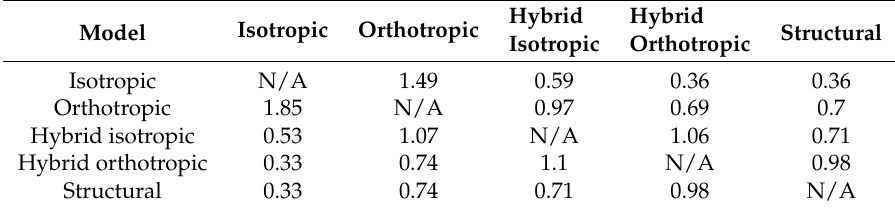
Table 7. Gradients of lines of best fit between each pair of adaptive models for maximum principal strains (above table diagonal) and minimum principal strains (below table diagonal).